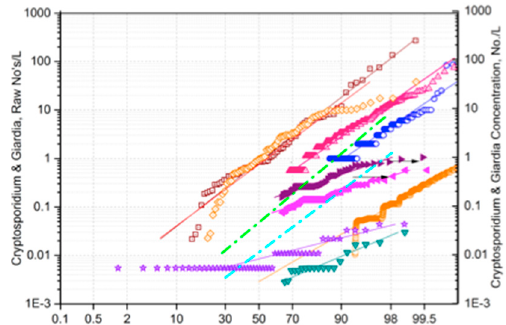
Figure 3. Cumulative probability distributions of Cryptosporidium ( C ) and Giardia ( G ) after Figure 8 [23], in descending order: C&G-66 USA sites, 1990; G-34 USA sites, 2001; C-34 USA sites, 2001; G-1yr USA site, 1992-3; C-1yr USA site 1992-3; C-2yr 1670 USA sites, 2010-12; G-1yr NE USA site, 2003; C-1yr NW USA site,